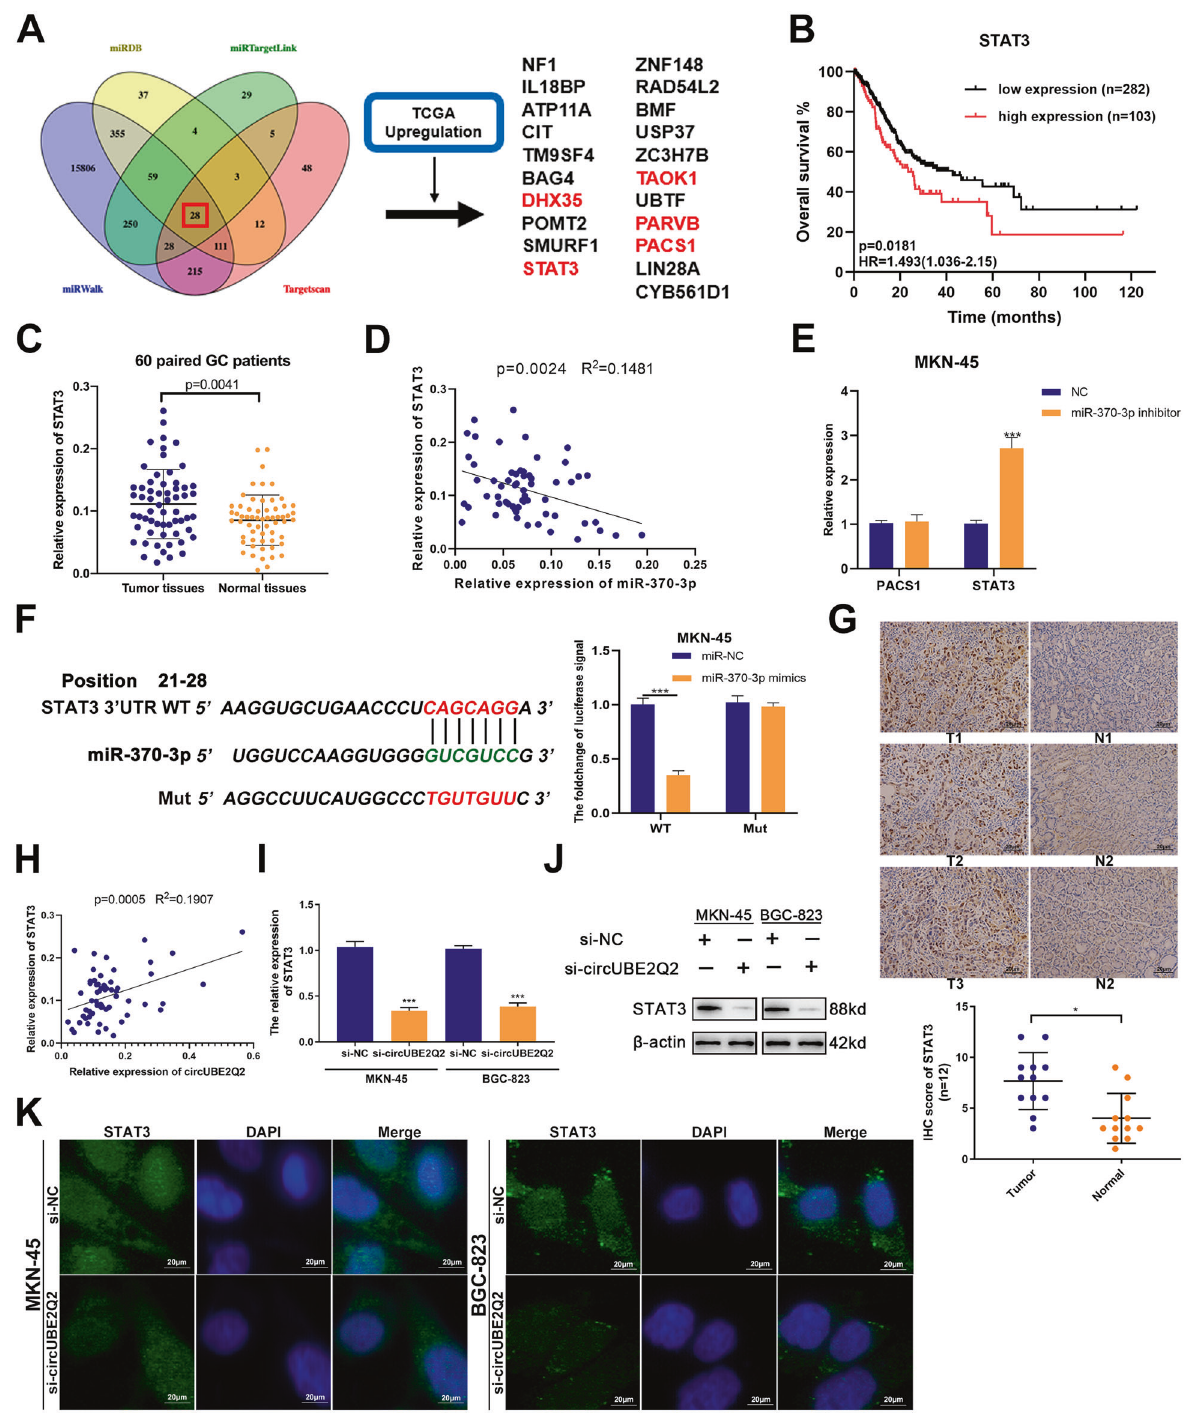
Fig. 4 STAT3 is a downstream target of miR-370-3p. A Venn diagram detailing the exploration of miR-370-3p downstream targets. B Overall survival analysis based on STAT3 expression in TCGA GC patients. The optimal cutoff was calculated by X-tile software. C mRNA levels of STAT3 in GC tissues and paired normal tissues detected by qRT-PCR ( n = 60). D Correlation of STAT3 and miR-370-3p expression in GC tissues and paired normal tissues ( n = 60). E The expression of PACS1 and STAT3 after miR-370-3p silencing in MKN-45 cells measured by qRT-PCR. F A dual-luciferase reporter assay to determine the direct binding between miR-370-3p and STAT3 in MKN-45 cells. G Expression of STAT3 detected via immunochemistry analysis (IHC) on 12 paired GC tumor tissues and normal stomach tissues, scale bar = 20 µm. H Correlation of STAT3 and circUBE2Q2 expression in GC tissues ( n = 60). I The expression of STAT3 in GC cells transfected with circUBE2Q2-speci fi c siRNA measured by qRT-PCR. J The protein levels of STAT3 in GC cells transfected with circUBE2Q2-speci fi c siRNA measured by western blottings. K Immuno fl uorescence staining for STAT3 in treated MKN-45 and BGC-823 cells, scale bar = 20 µm. Data are expressed as the mean ± SD. * p < 0.05, ** p < 0.01, *** p < 0.001.